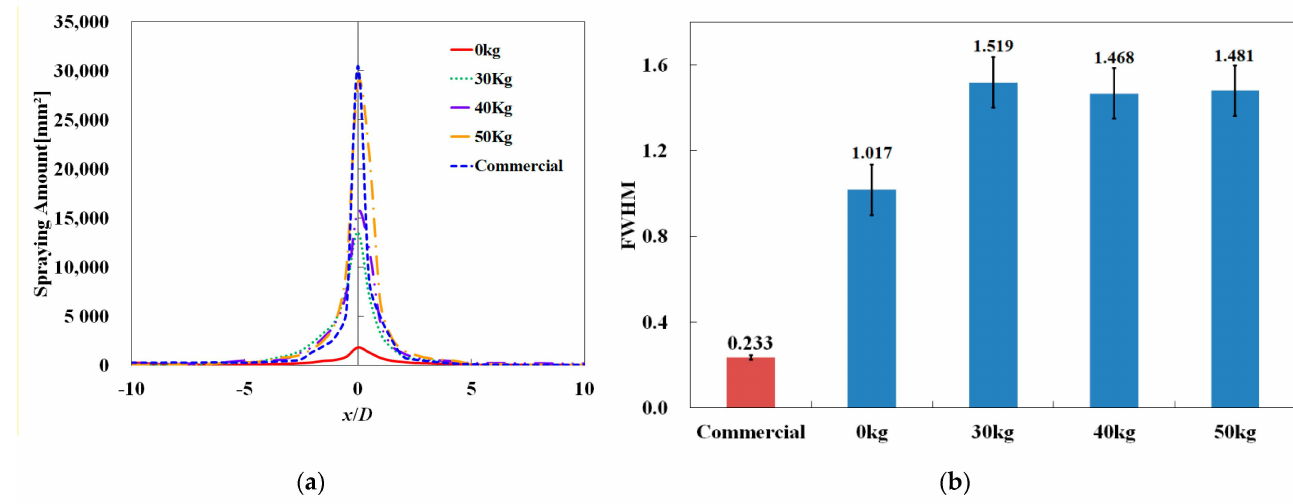
Figure 12. ( a ) Variations of spraying amount along the radial position and ( b ) corresponding full width at half maximum